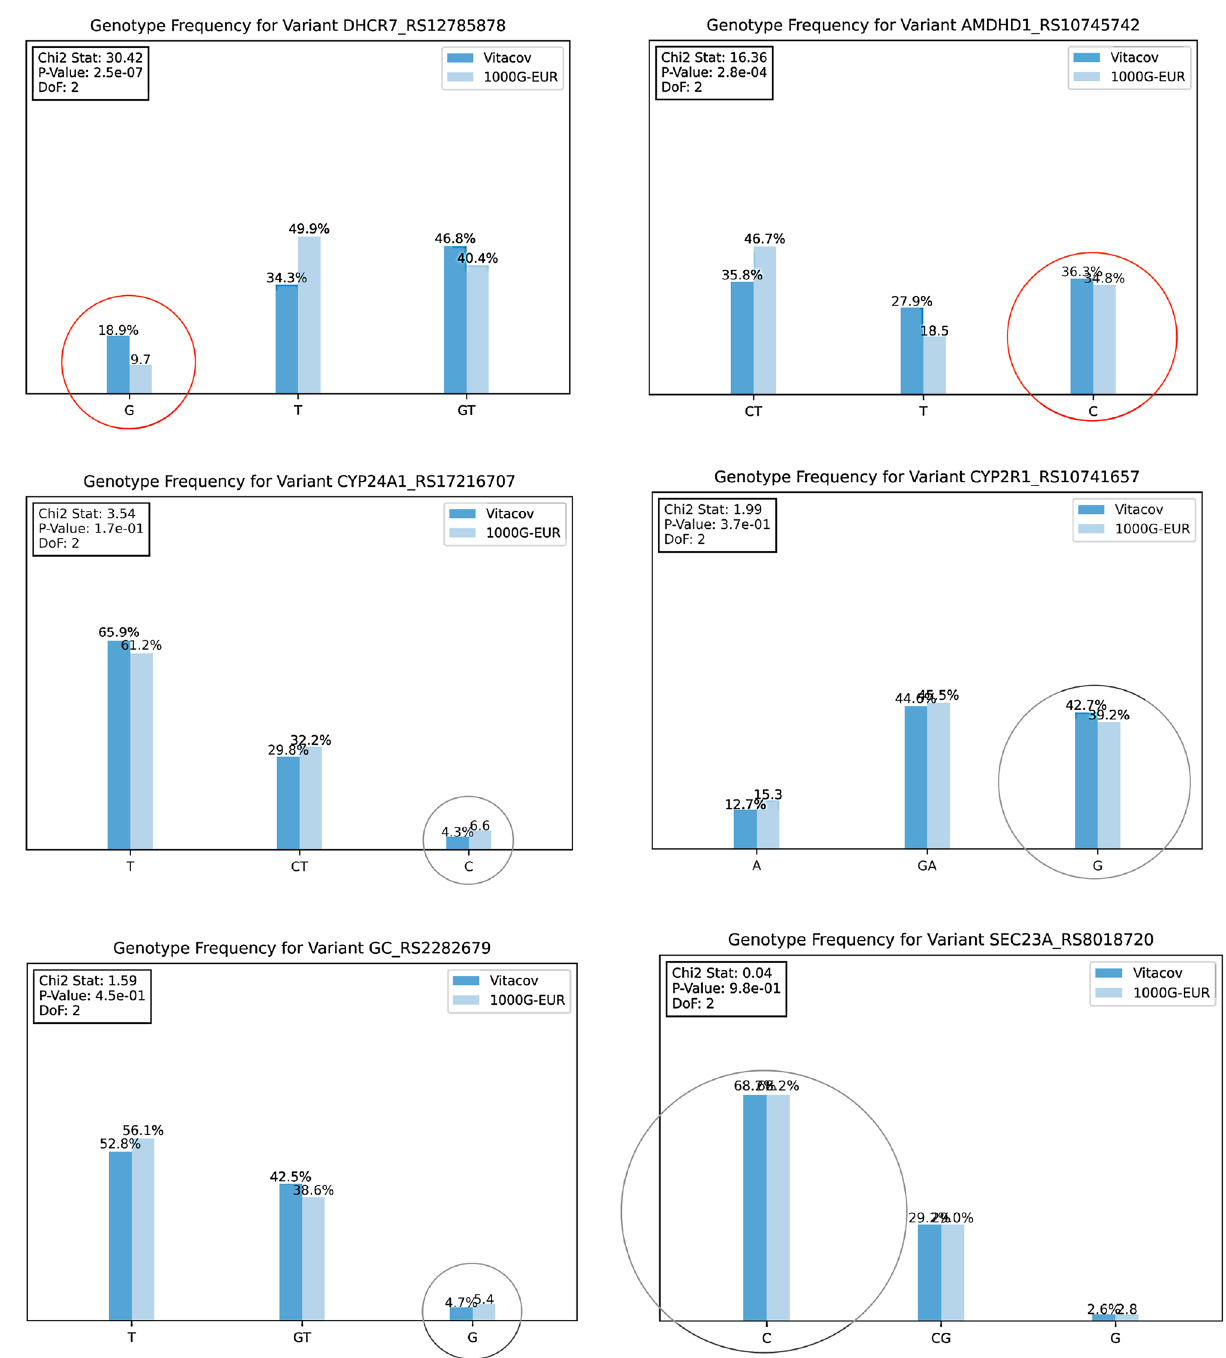
Figure 3. Comparison of the impact genotypes’ frequency in the Portuguese and European populations. Circles highlight the risk genotype. The red circles show the risk genotypes from variants with a statistically significant difference between these two populations ( p -value = 2.5e−7 for DHCR7 RS12785878, and p -value = 2.8e−4 for AMDHD1